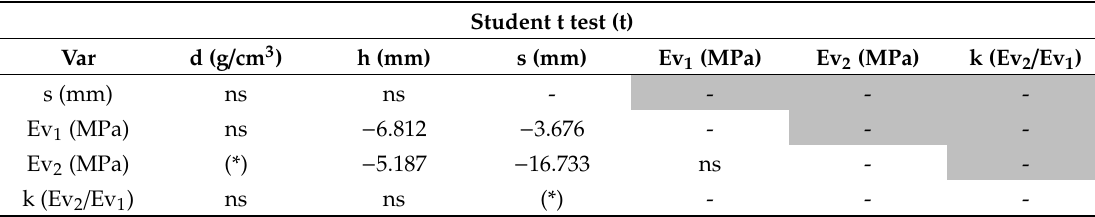
Table 18. Slate random fill in crown significance matrix.